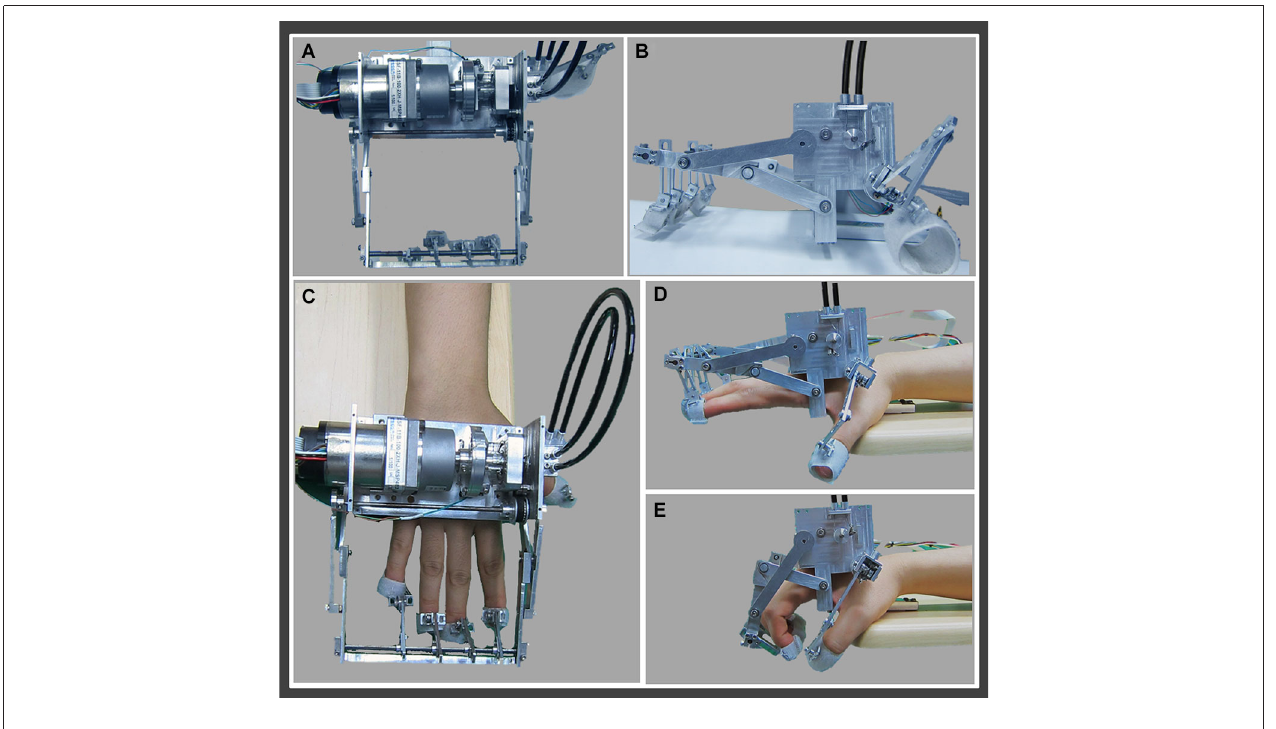
extension (second to fifth fingers) and thumb abduction state by the rehabilitation robotic hand, (E) finger flexion (second to fifth fingers) and thumb adduction state by the rehabilitation robotic